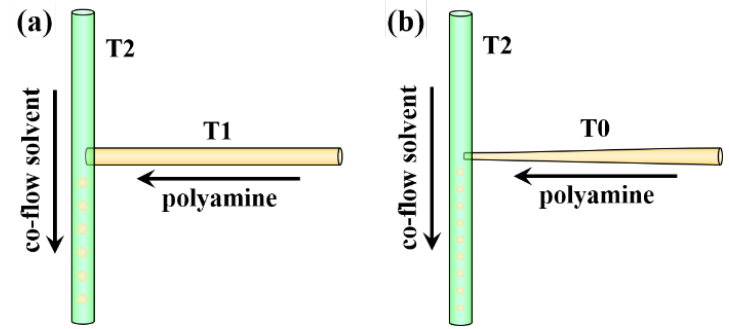
Figure 1. Configuration of the adopted T-junction units. ( a ) T-junction T1/T2, and ( b ) T-junction T0/T2.